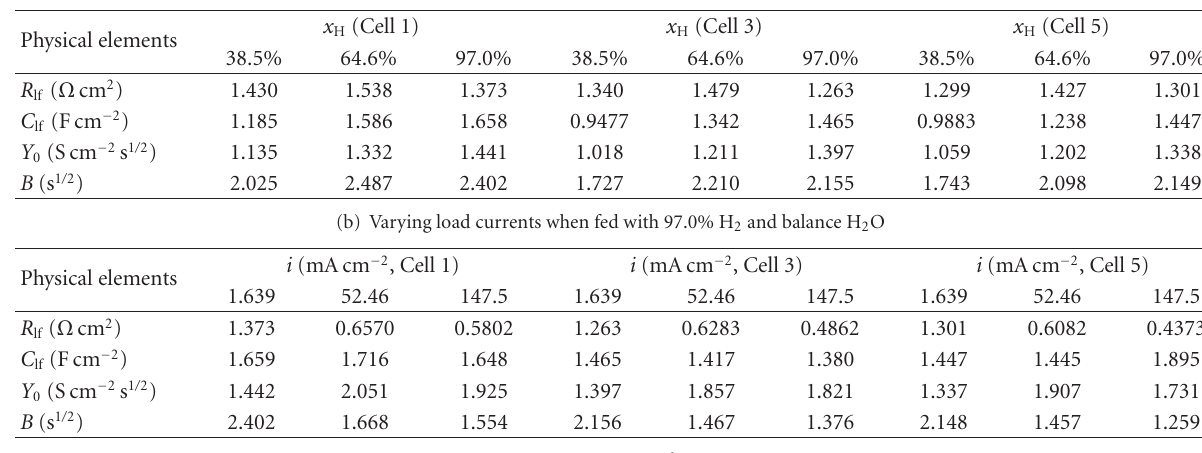
Table 3: Values for a parallel RC fitted to the low-frequency impedance loops of three cells in a five-cell planar stack operating at 800 ◦ C. (a) The SOFCs were fed with 38.5 ∼ 97% H 2 , 3% H 2 O, and balance N 2 , and operated at 1.69 mAcm − 2